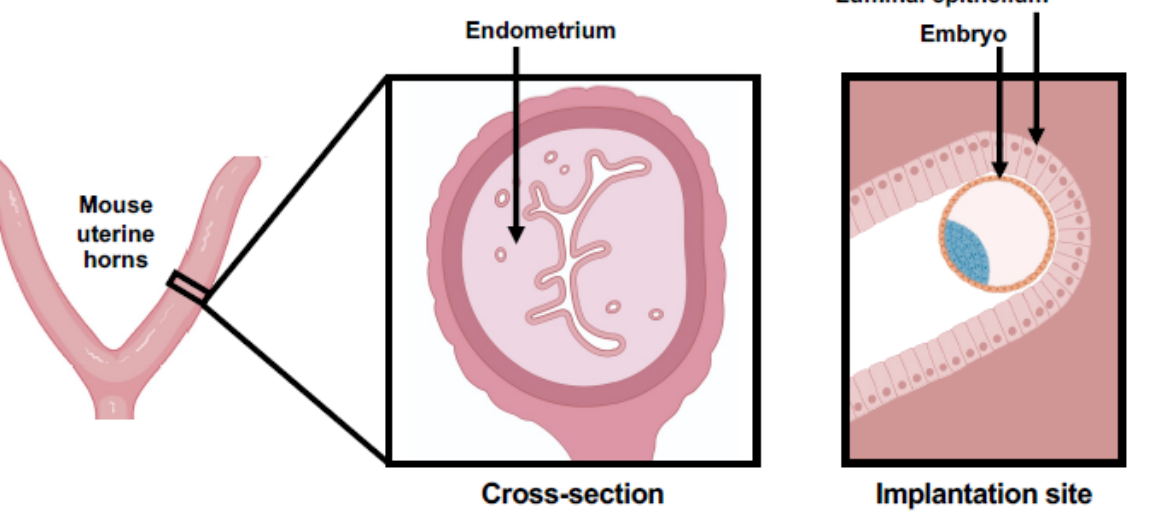
Figure 2. Schematic illustration of the murine uterus and the close contact between the blastocyst and the endometrium at the start of implantation. Shown are the two horns and a cross-section of the uterus, as well as the implantation site where an embryo is in the implantation chamber on pregnancy d4.5. Created with BioRender.com.